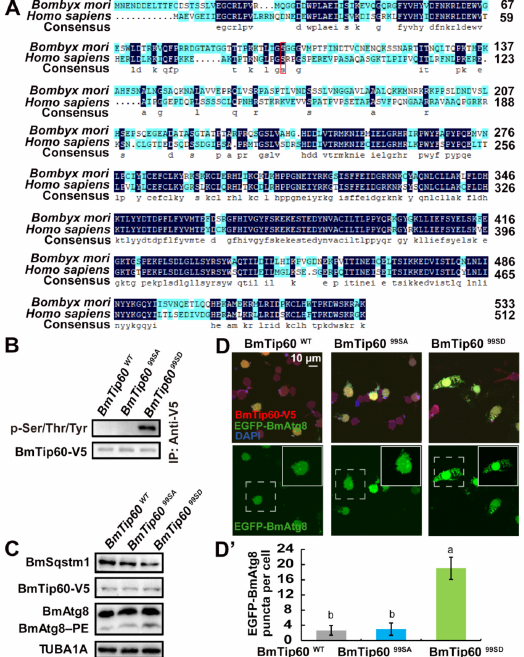
Figure 2. Phosphorylation at Ser99 is required for BmTip60-mediated autophagy. ( A ) Amino acid sequences of Tip60 homologs in B. mori and H. sapiens are aligned by DNAMAN software. Dark blue: conserved amino acid sequence, light blue: nonconservative amino acid sequence. Red box: the conserved phosphorylation site. ( B ) Phosphorylation level of immunoprecipitated BmTip60 after overexpression of BmTip60-V5 , BmTip60 99SA -V5 , and BmTip60 99SD -V5 in BmN cells for 48 h, respectively. WT: wild-type; 99SA: Serine99 mutated to Alanine99; 99SD: Serine99 mutated to Aspartic99. ( C ) Protein levels of BmSqstm1, BmTip60, and BmAtg8 after overexpression of BmTip60- V5 , BmTip60 99SA -V5 , or BmTip60 99SD -V5 in BmN cells for 48 h. ( D ) Observation of EGFP-BmAtg8 and immunostained BmTip60-V5/BmTip60 99SA -V5/BmTip60 99SD -V5 under nutrient-rich conditions in BmN cells. Scale bar: 10 micron. White solid box: magnified field. White dashed box: original field. ( D’ ) Quantification of EGFP-BmAtg8 puncta in (D). One-way analysis of variance was performed by SPSS in the whole figure; different lowercase letters mean p < 0.05, n = 50 cells. The authors would like to apologize for any inconvenience caused to the readers by these